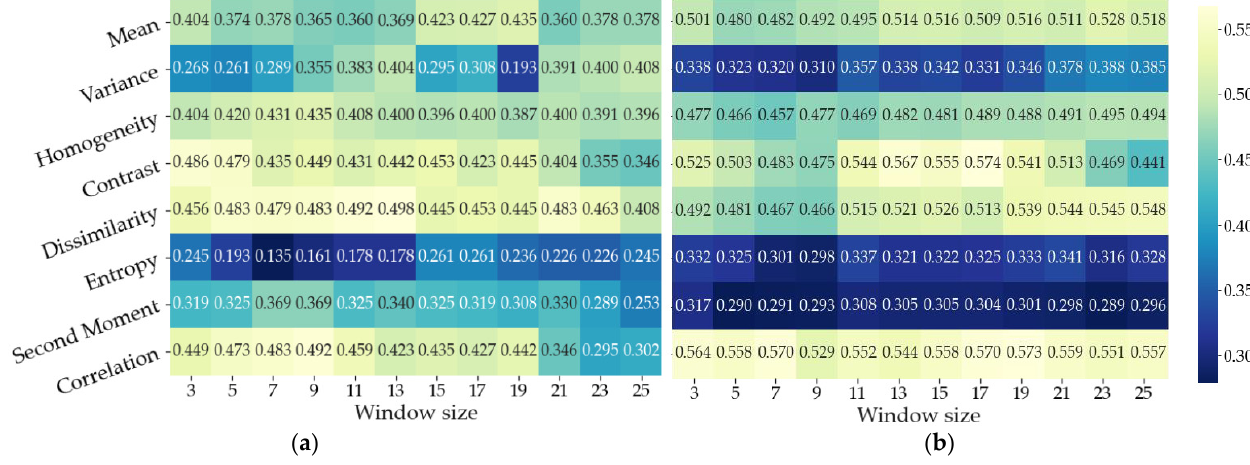
Figure 5. Kendall correlation coefficients between the PC1s of texture features and the disease rates on May 3 ( a ) and May 8 ( b ).